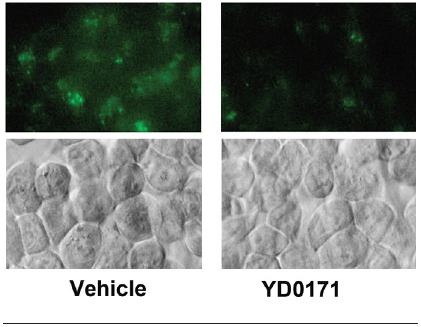
S production by Figure 5. Inhibition of H 2 YD0171 in HCT116 cells. Effect of YD0171 (1 mmol/L) on cellular H2S production is shown by the AzMC-based live cell assay. Top panel: green color shows AzMC fluo- rescence. Bottom panel: phase contrast images of the same visual field. Data shown are the representative of n = 3 independent determinations.